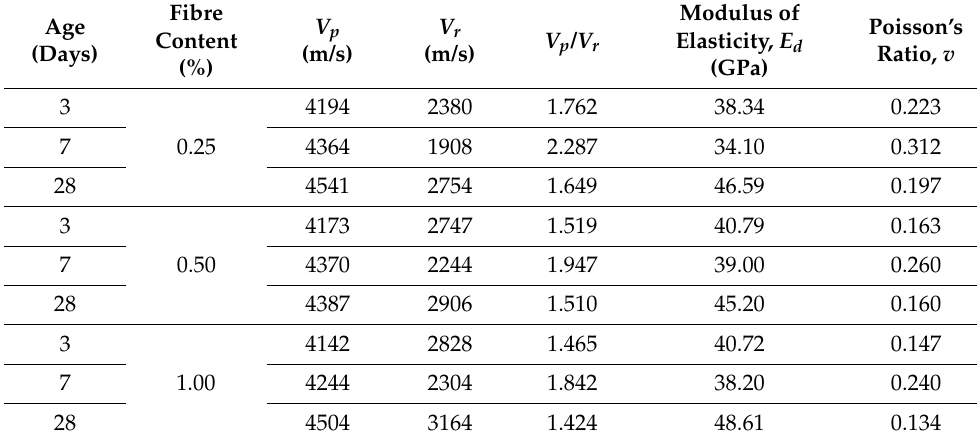
Table 10. Modulus and Poisson’s ratio for beam with 30 mm fibre.